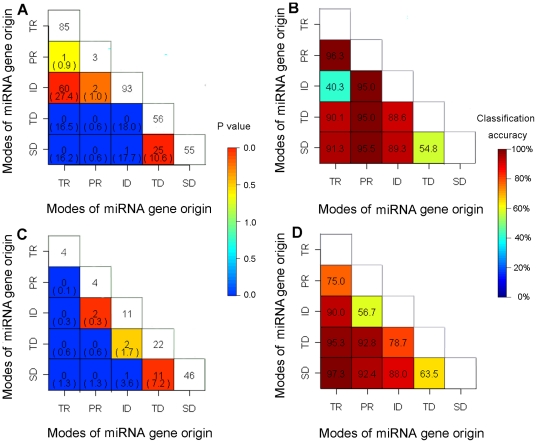
Relationships among different origin modes of miRNA genes.(A) and (B) are for O. sativa, while (C) and (D) are for A. thaliana. TR represents TE-related, PR represents pseudogene-related, ID represents inverted duplication, TD represents tandem duplication, and SD represents segmental duplication. (A) and (C) are intersection number of miRNA gene sets with different origin modes. Number in the center of each lattice represents intersection number of miRNA gene sets with different origin modes represented by vertical and horizontal axes, and number in parentheses is values of random state deduced from 100,000 Monte Carlo simulations. Lattice color represents P-value between real and simulation values, red lattice represents that real value is larger than simulation value, and blue lattice represents that real value is smaller than simulation value. (B) and (D) are classification accuracy of miRNA gene sets with different origin modes.